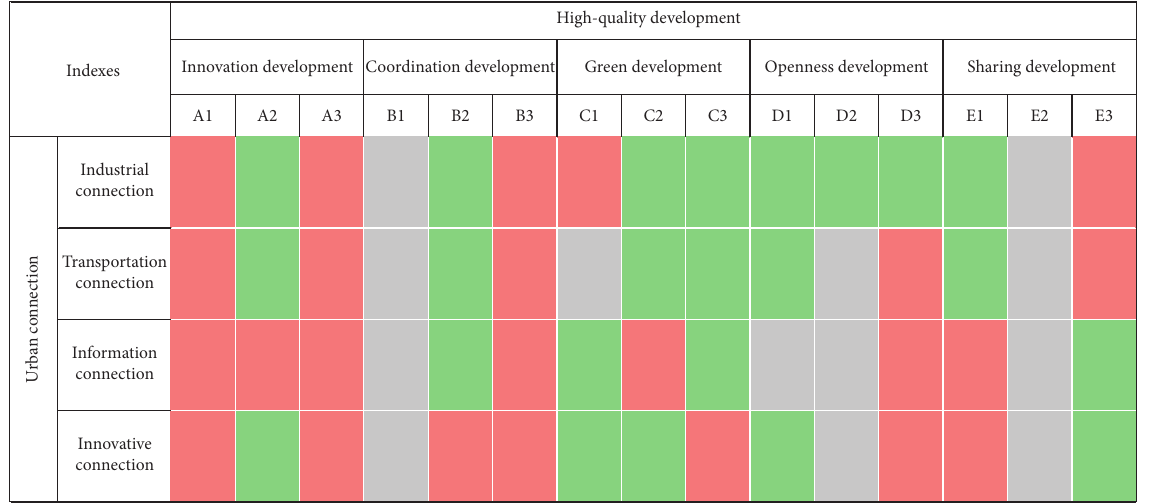
Table 4: Correlation test between UCI and HDI in Lanzhou-Xining urban agglomeration.